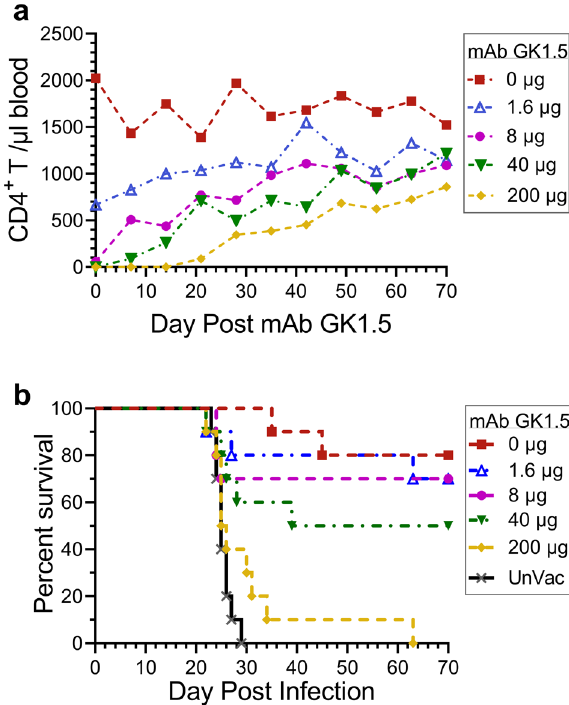
Fig. 4 The effect of partial CD4 + T cell depletion on vaccine- mediated protection. a Naïve BALB/c mice were injected with the indicated amount of anti-CD4 mAb GK1.5 on day − 2. Every other week starting on day 0, the mice underwent cheek bleeds to determine the CD4 + T cell count in peripheral blood. Four mice per group were studied, staggered so that two mice per group were tested each week. Data were mean values. b BALB/c mice were vaccinated thrice at biweekly intervals with GP-Cda1/Cda2. Twelve days after the last boost, mice were injected with the indicated amount of GK1.5. Two days later, the mice received a pulmonary challenge with C. neoformans and were monitored for survival until day 70. UnVac unvaccinated. Data were from two independent experiments, each with 5 mice/group. Signi fi cant ( P < 0.005, Mantel – Cox log-rank test) survival compared with unvaccinated mice was seen for those groups of mice receiving a GK1.5 dose ≤ 40